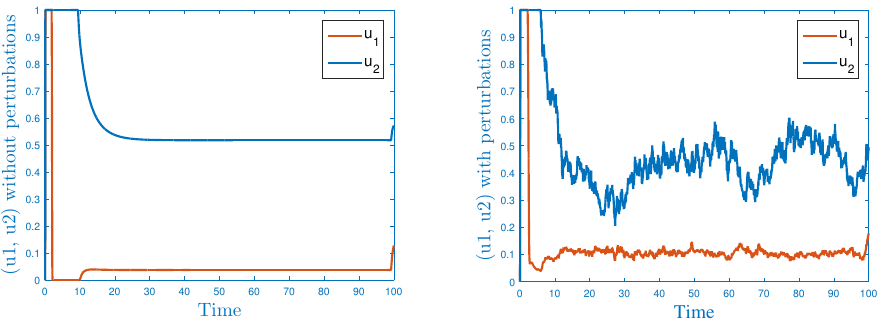
Figure 9. The curves exhibit the time-evolution of the control measures obtained from simulating the models: deterministic and